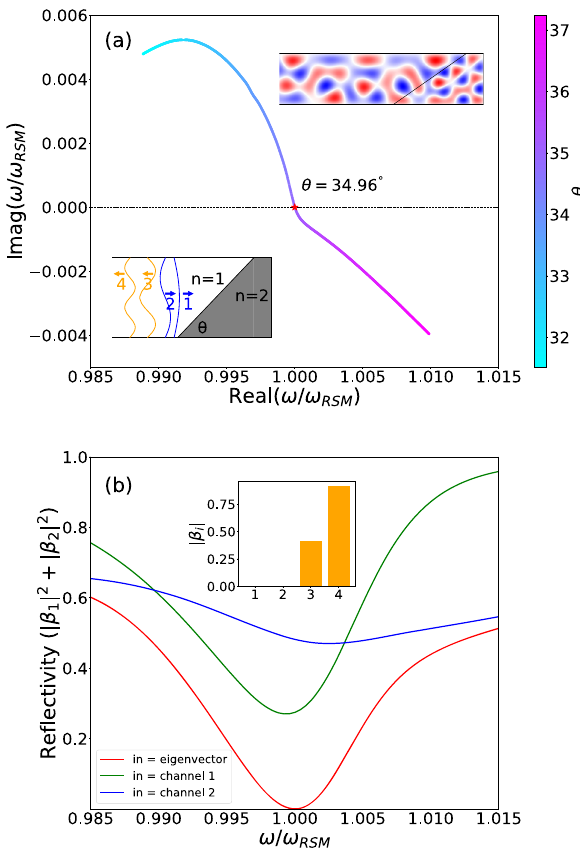
Figure 6: Illustration of a reflectionless scattering mode (RSM) in a four-modewaveguideactingasamodeconverterfromasuperposition of input waveguide modes 1 and 2 into output modes 3 and 4, as the wedgeangleoftheboundarybetweentheindex1andindex2regionis varied. (a) Trajectory of R-zero in the complex frequency plane as wedge- angle θ is tuned. The R-zero crosses the real axis at θ (cid:1) 34 . 96 ° (red star), becoming an RSM. Insets show a schematic of the structure andtherealpartoftheRSM fi eldpro fi le.(b)Re fl ectivityintomodes1 and 2 with different incident wavefronts for θ (cid:1) 34 . 96 ° . Red curve has input α 0 ( ω ) , de fi ned to be the eigenvector of R † the smallest eigenvalue. R in ( ω ) is the 2 × 2 upper left block of the scatteringmatrix.Theincidentwave α 0 ( ω RSM ) (cid:1) [ 0 . 7982 , − 0 . 5642